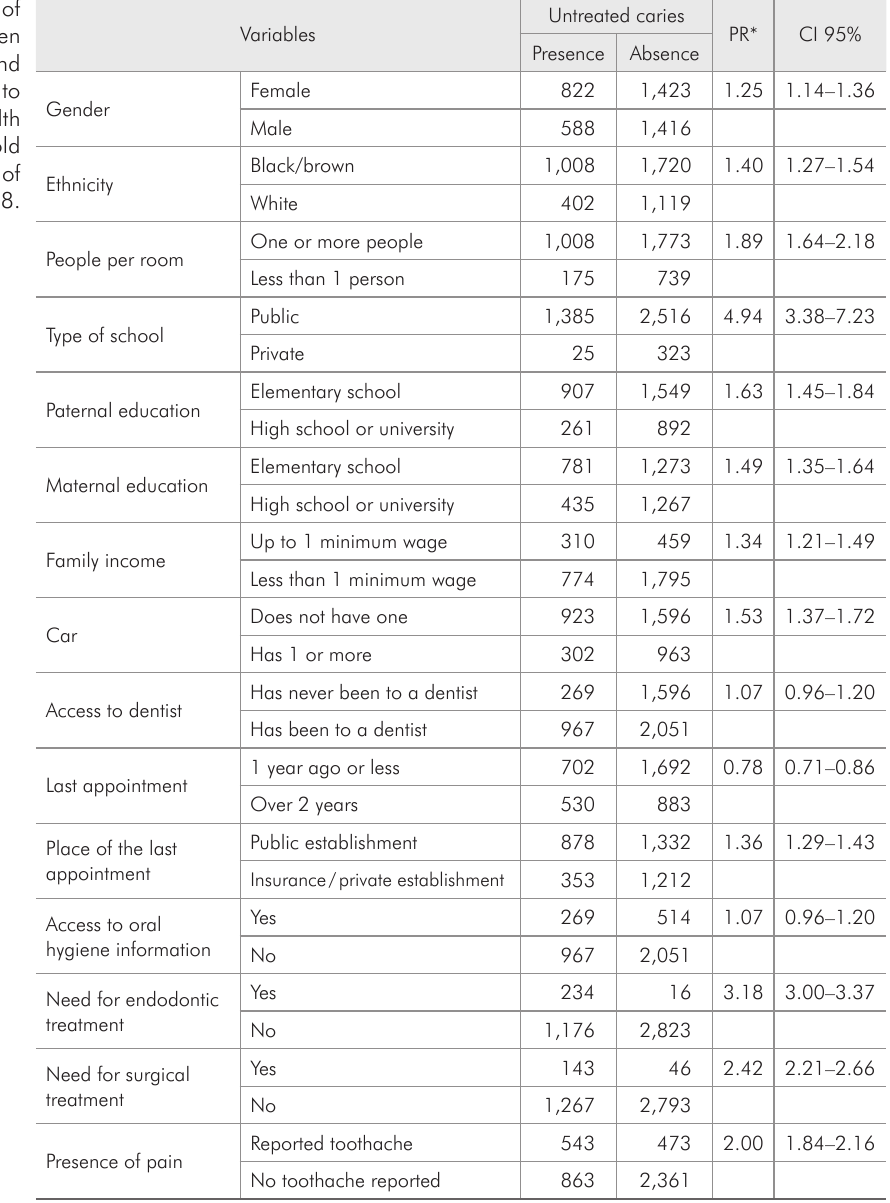
*PR: prevalence ratio adjusted for the sampling model per conglomerate, and considering the population size.